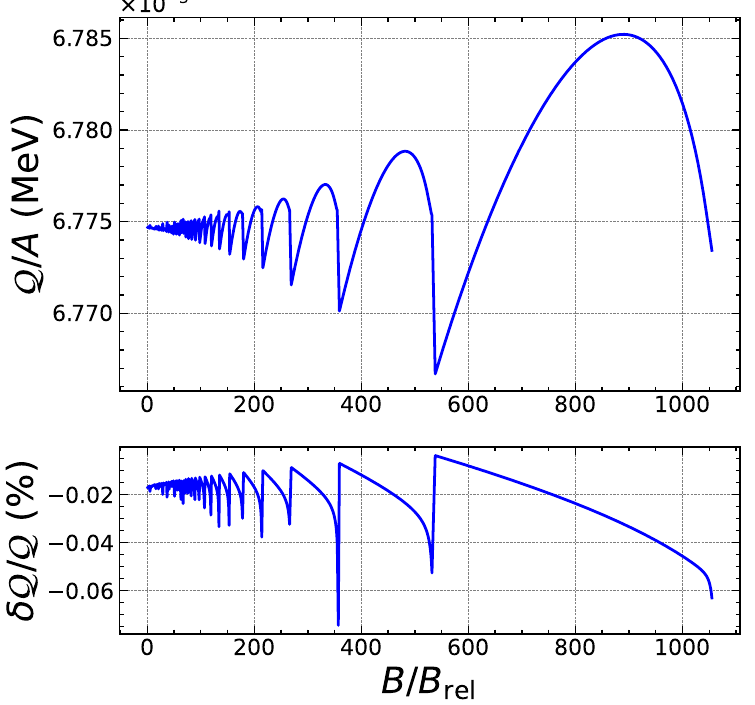
Figure 13. Top panel : Exact heat released per nucleon from electron captures by 122 Zr as a function of the magnetic field strength B (cid:63) = B / B rel up to the onset of the strongly quantizing regime. Bottom panel : Relative error (in %) of the approximate analytical